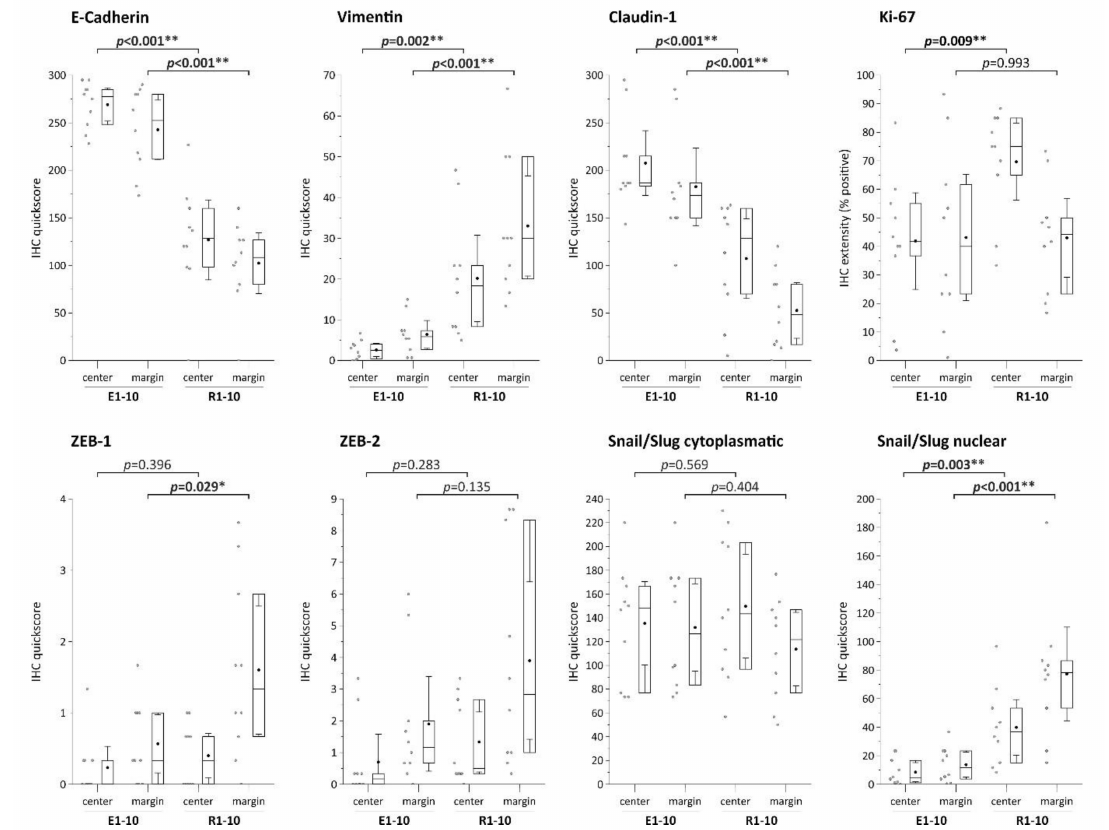
Figure 3. Semi-quantitative analyses of IHC staining of EMT markers using quickscore [29]. Box plots show the 25th and 75th percentiles, median (horizontal line), mean (filled circle), and 95% confidence interval (whiskers). For representative images of IHC staining, see Figure 2. * indicates significance ( p < 0.05), ** indicates high significance ( p <